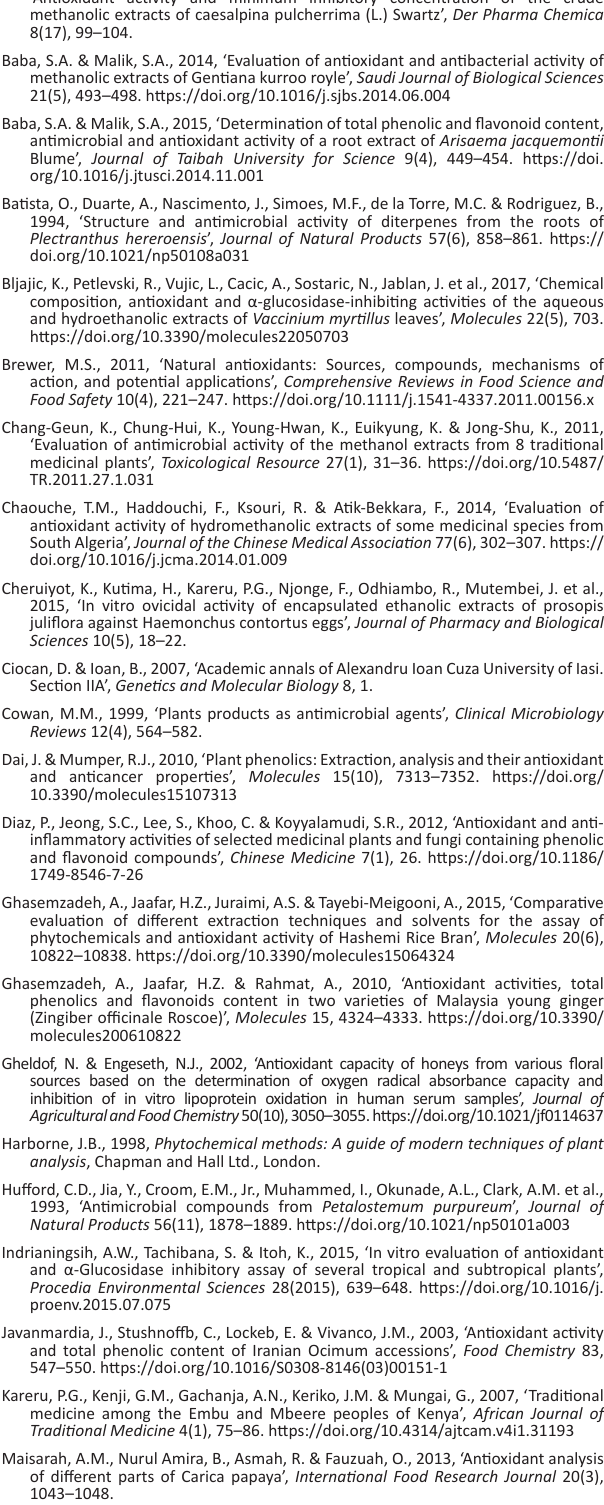
, total phenols and total 50